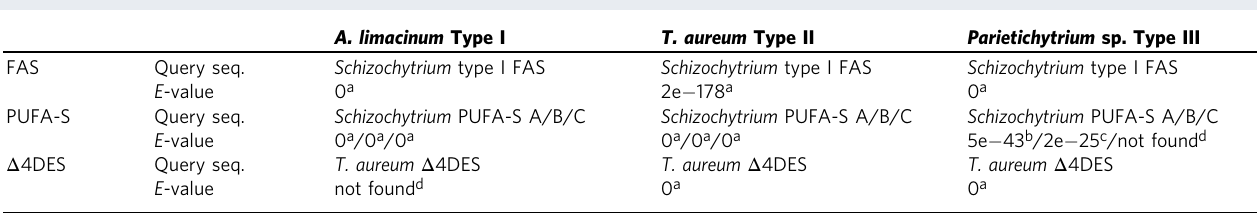
Table 2 Genes responsible for the synthesis of DHA found in the draft genomes of A. limacinum , T. aureum , and Parietichytrium